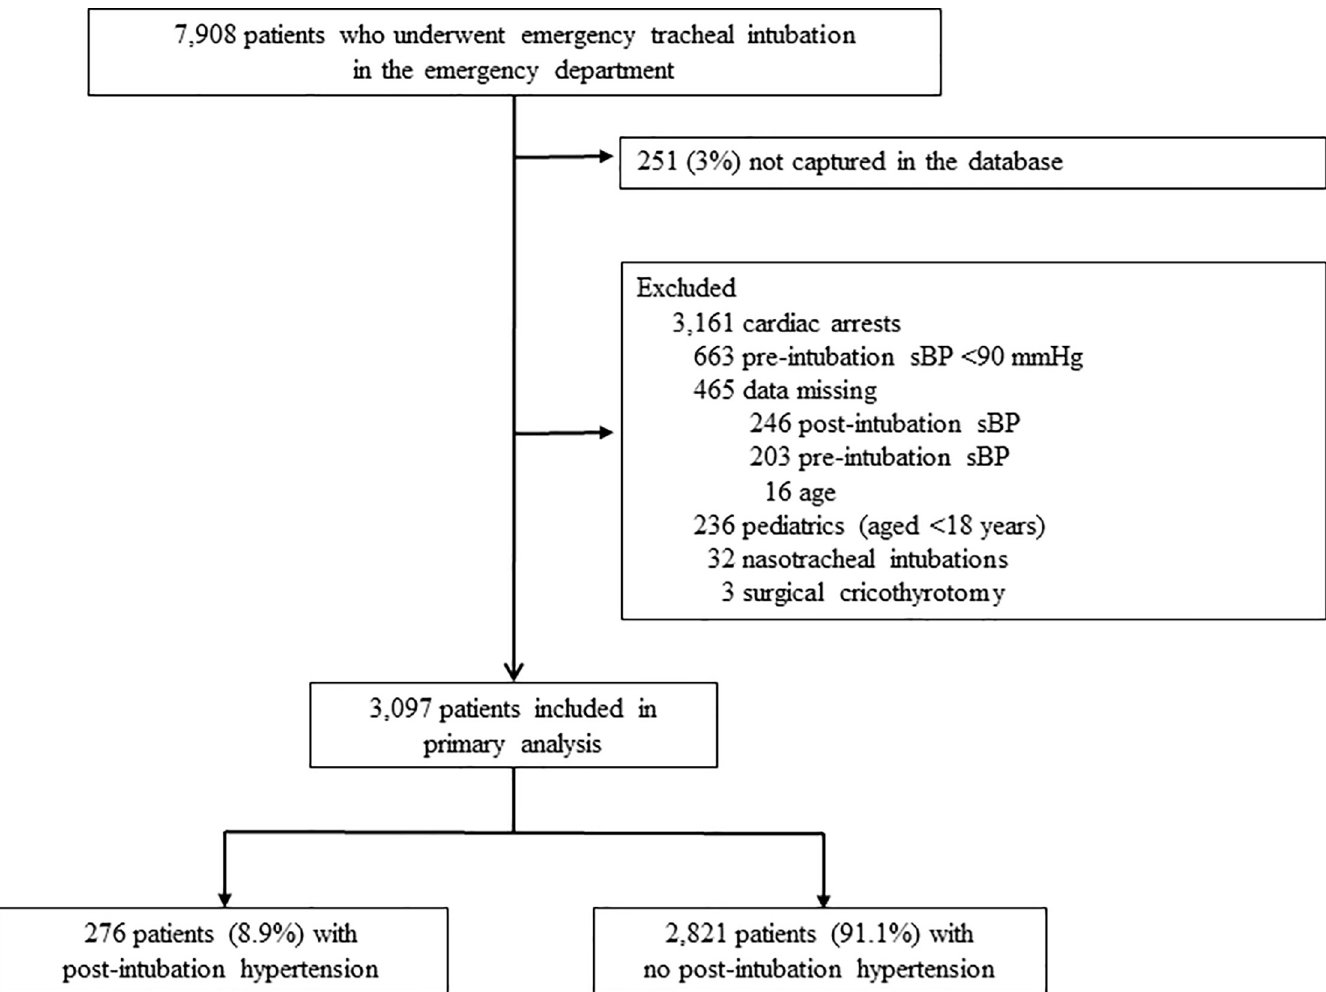
Fig 1. Patients receiving tracheal intubation in the emergency department. Abbreviation: sBP, systolic blood pressure.